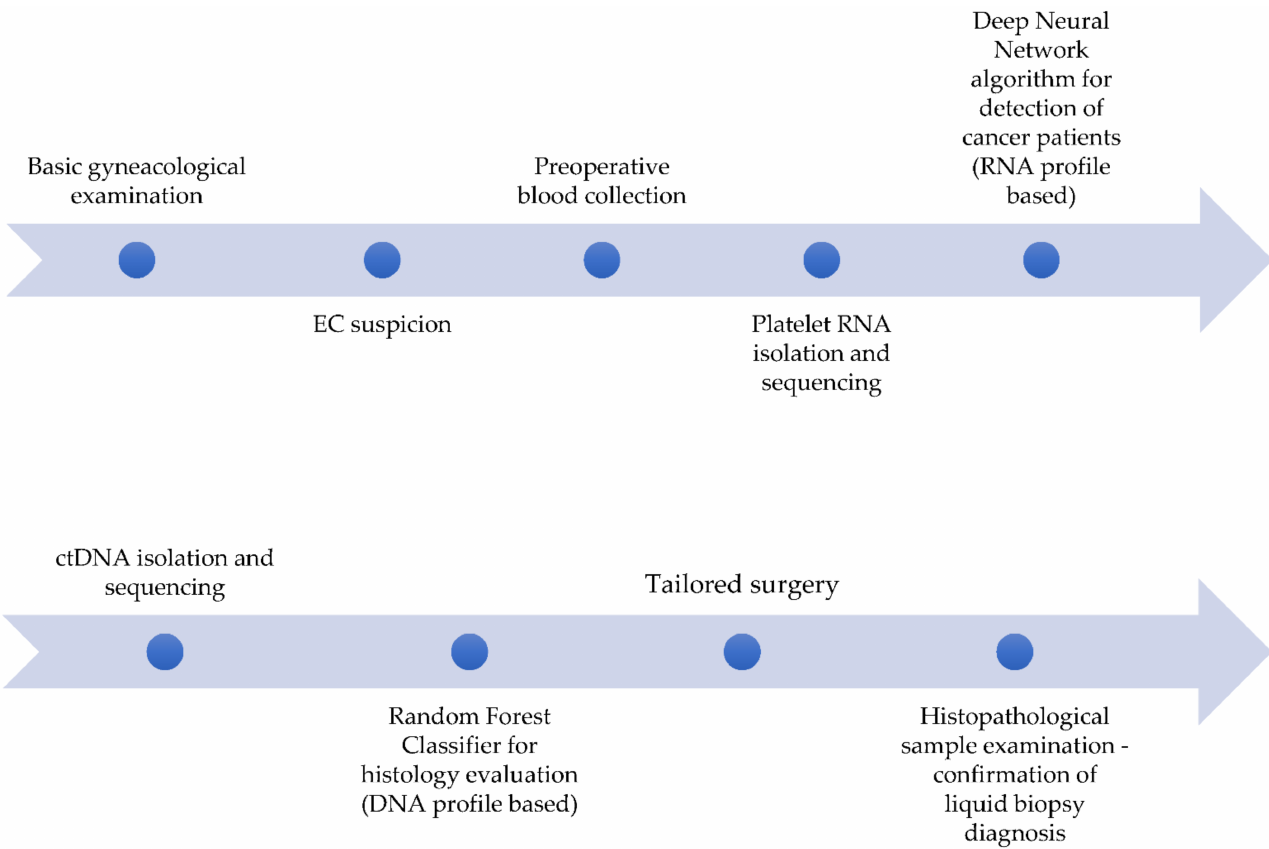
Figure 1. The concept of the future EC diagnosis and initial therapy planning based on the proposed